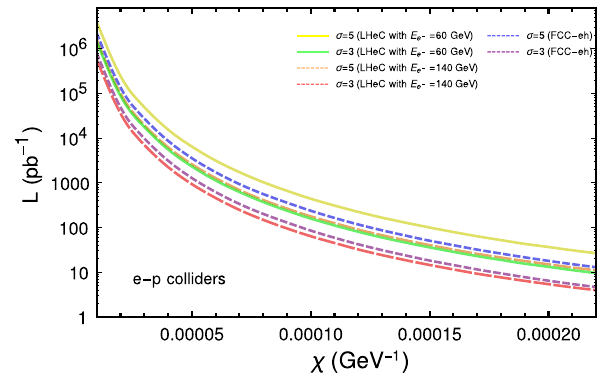
Fig. 8 Integrated luminosity required for observing the signal-2 at the 3 σ and 5 σ statisticalsignificance at different values of χ at e-p colliders